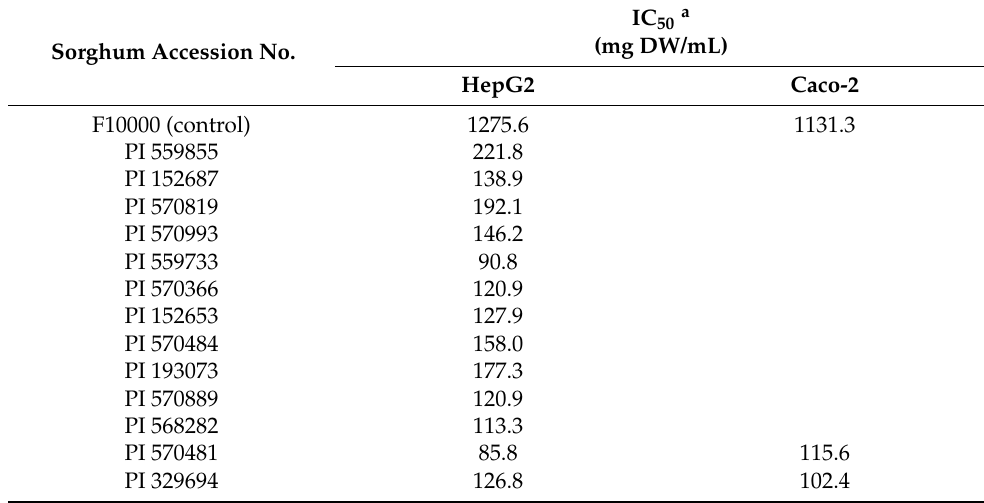
Table 2. IC 50 Values of specialty sorghum phenolic extracts in HepG2 and Caco-2 cells. Sorghum Accession No.